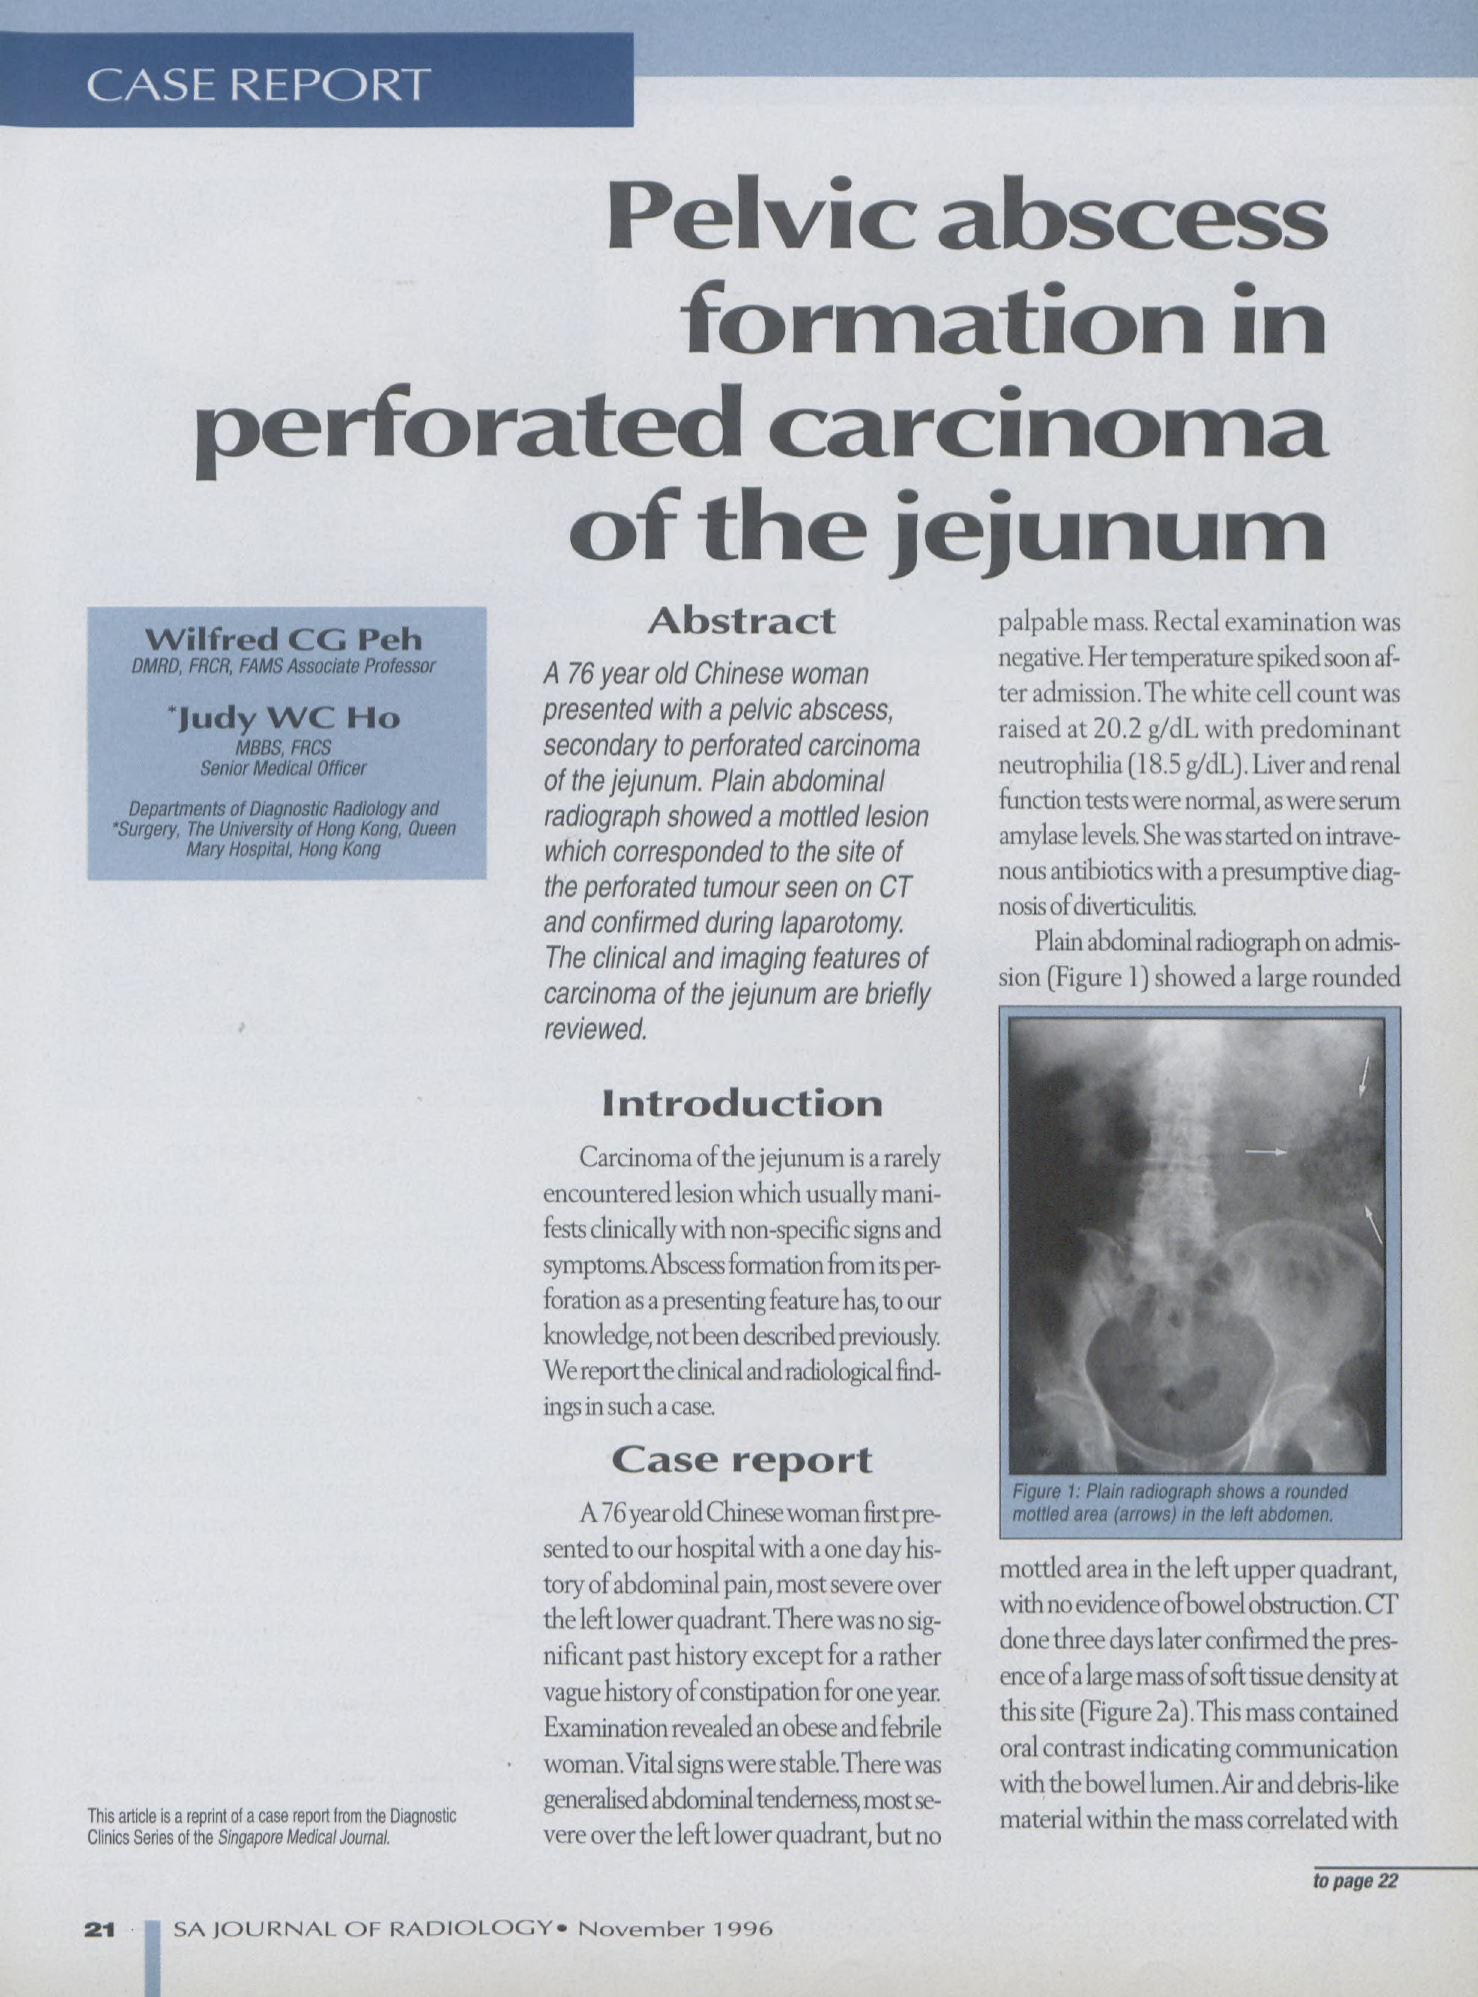
Figure 1: Plain radiograph shows a rounded mottled area (arrows) in the left abdomen. mottled area in the left upper quadrant, with no evidence ofbowel obstruction.